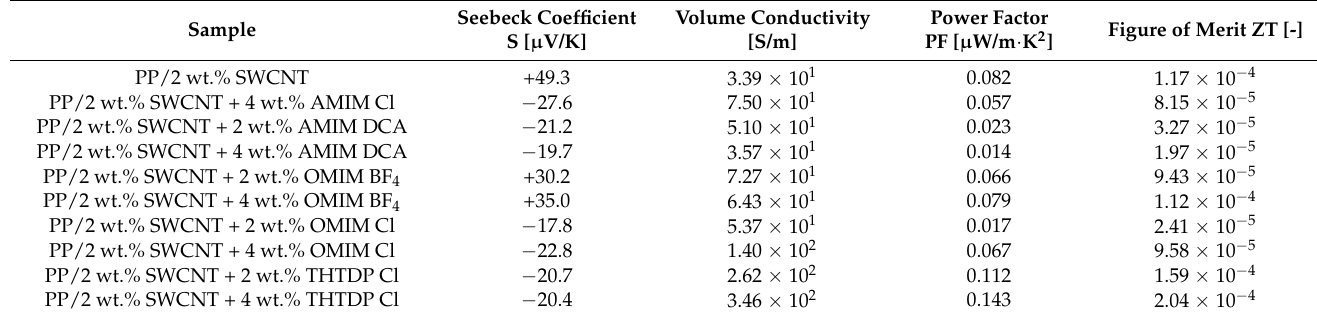
Table 4. Thermoelectric parameters at 40 ◦ C of the PP/2 wt.% SWCNT composites mixed with different ILs shown in Figure